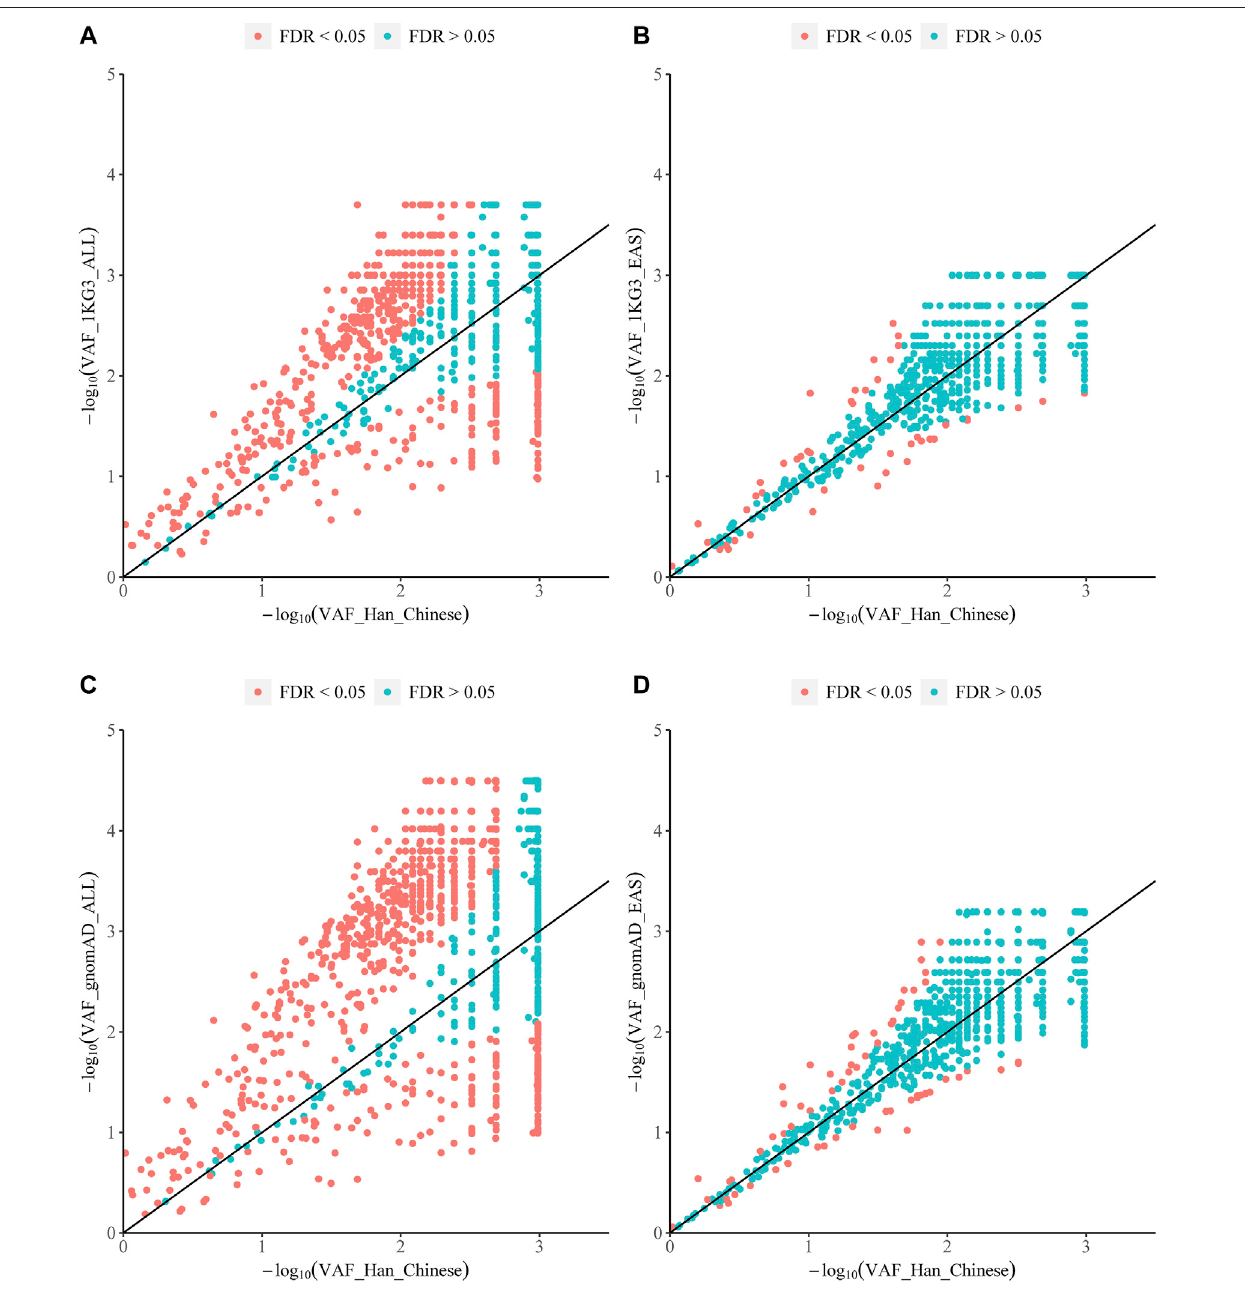
FIGURE 4 | Compared with the mutation frequencies of all populations in the 1KG3 and gnomAD databases, 1,790 and 1,920 genetic mutations are statistically different (FDR < 0.05). Compared with the mutation frequencies of the East Asian populations in the 1KG3 and gnomAD databases, respectively. There were statistical differences between 393 and 333 genetic variants (FDR < 0.05). VAF_Han_Chinese: variant allele frequency in the central Han Chinese population; VAF_1KG3_ALL: VariantAlleleFrequencyforallpopulationsin1KG3;VAF_1KG3_EAS:VariantAlleleFrequencyforEastAsianpopulationin1KG3;VAF_gnomAD_ALL:VariantAllele Frequency for all populations in gnomAD; VAF_gnomAD_EAS: Variant Allele Frequency for East Asian population in gnomAD.